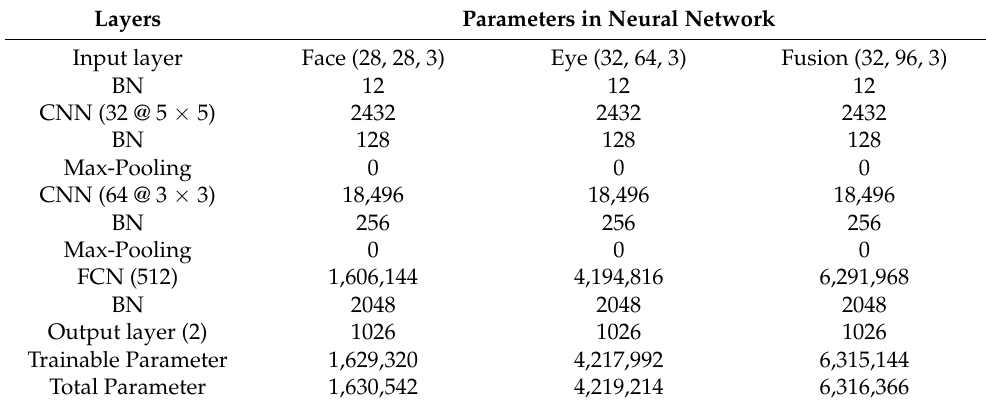
Table 2. The number of parameters in the training model with different types of input.